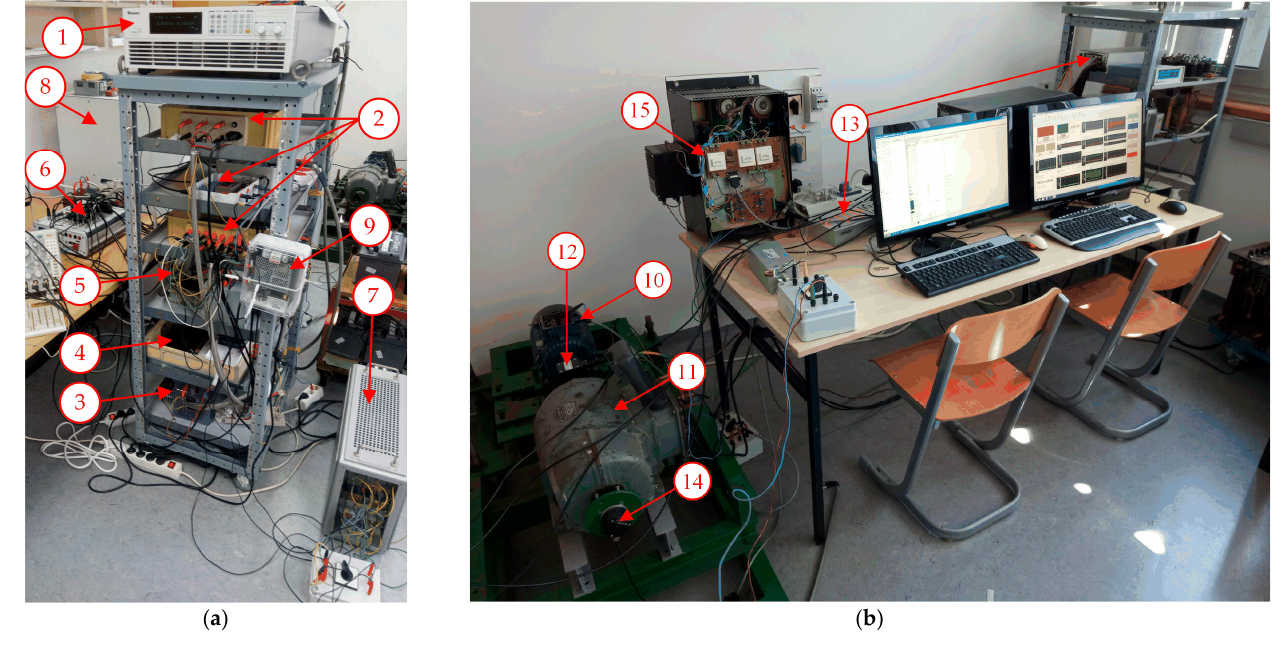
Figure 13. Laboratory setup of the proposed system: ( a ) WES components; ( b ) qZSI and PV components.